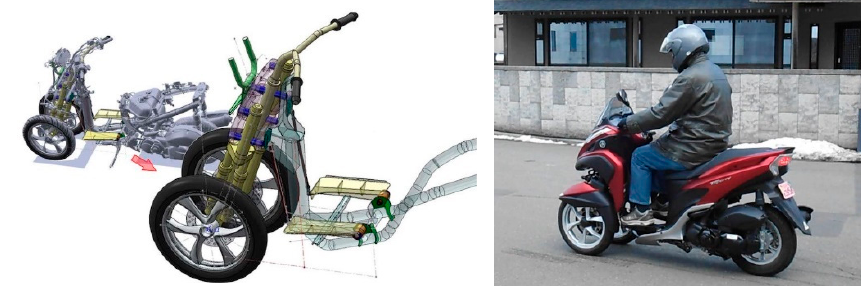
Figure 2. Self-standing mechanism was devised.